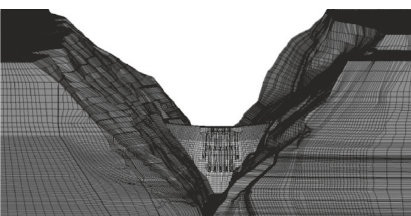
Figure 9: Three-dimensional finite element model of the Jinping-I arch dam (upstream viewpoint).